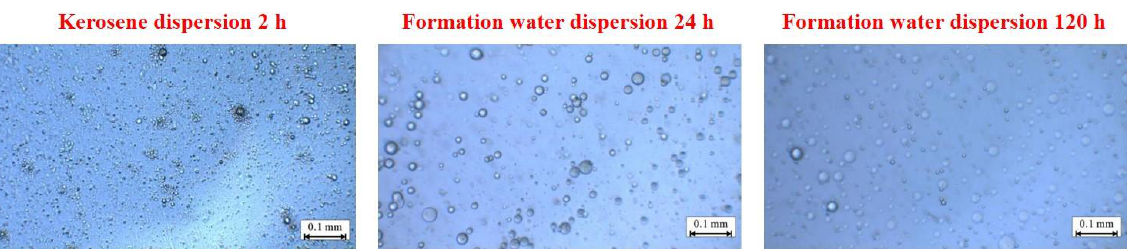
Figure 2. Micrograph of microspheres (WQ-100) after dispersion.